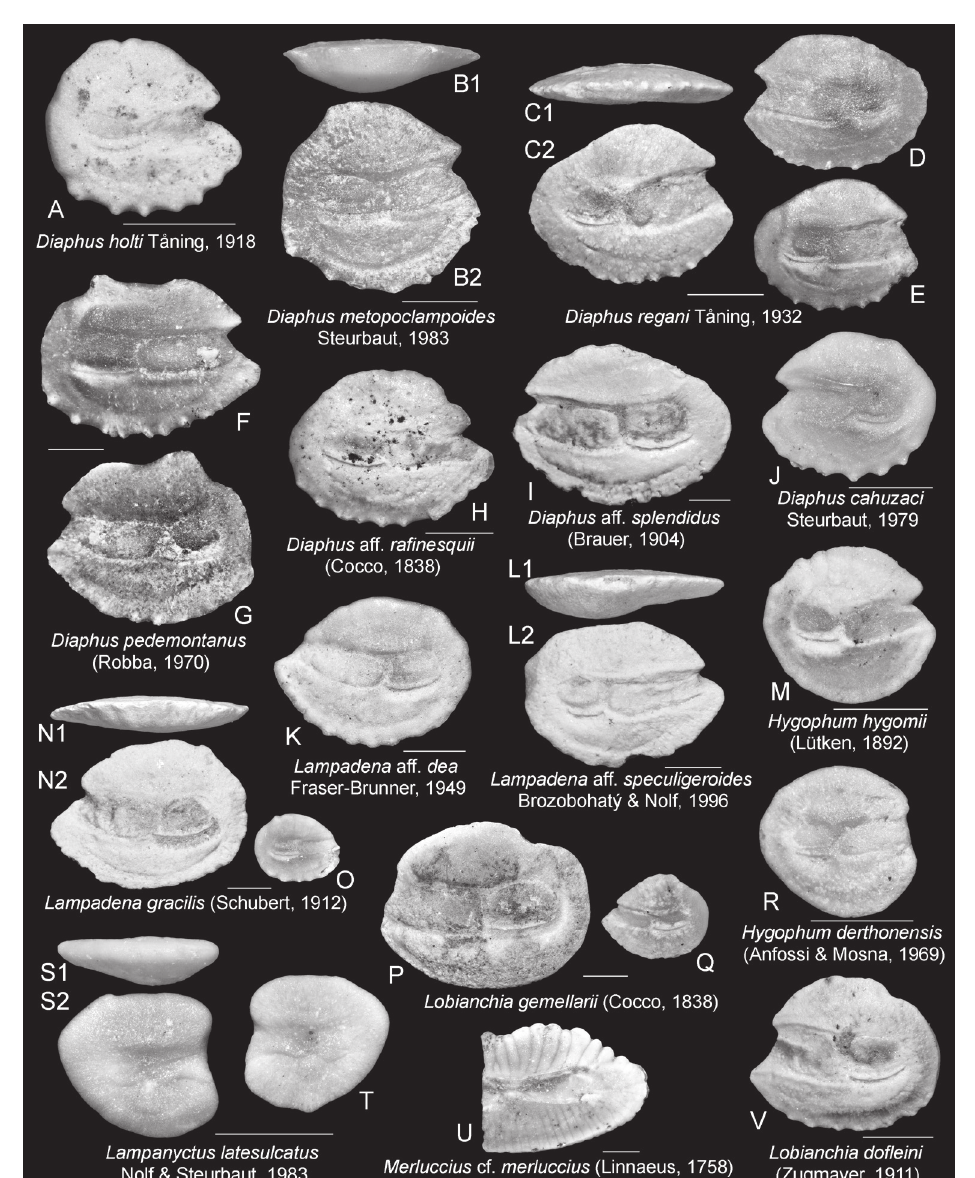
Fig. 5. Tortonian fish otoliths from northern Italy. A . Diaphus holti Tåning, 1918, Mondovi,